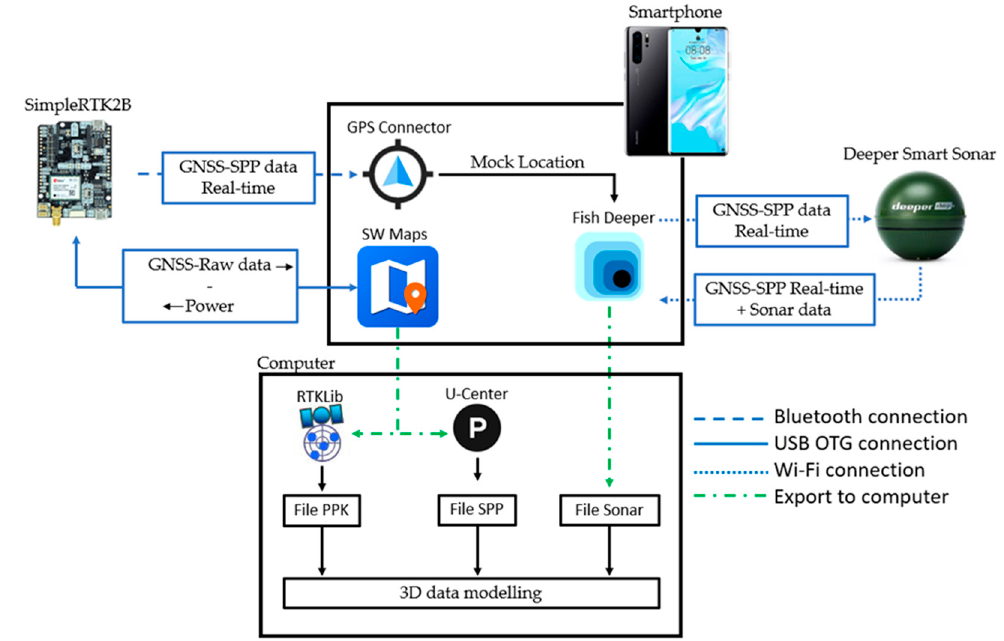
Figure 1. Synthetic pipeline of the G > S > P Sys functioning.